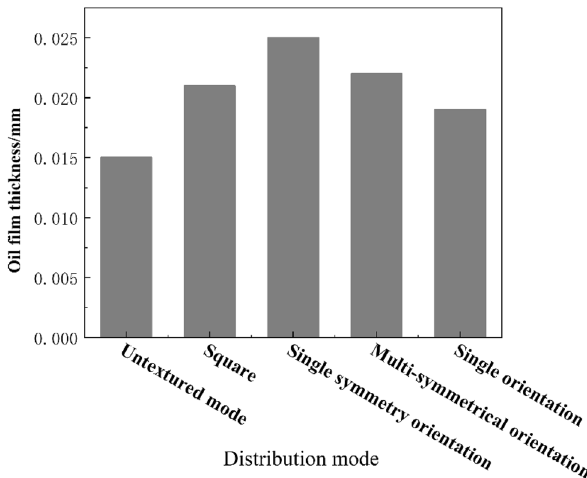
Figure 9. Oil film thickness of texture array with different